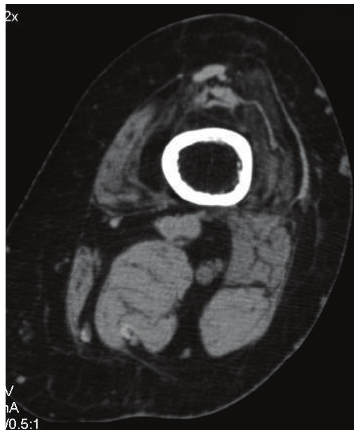
Figure 4: Complete quadriceps